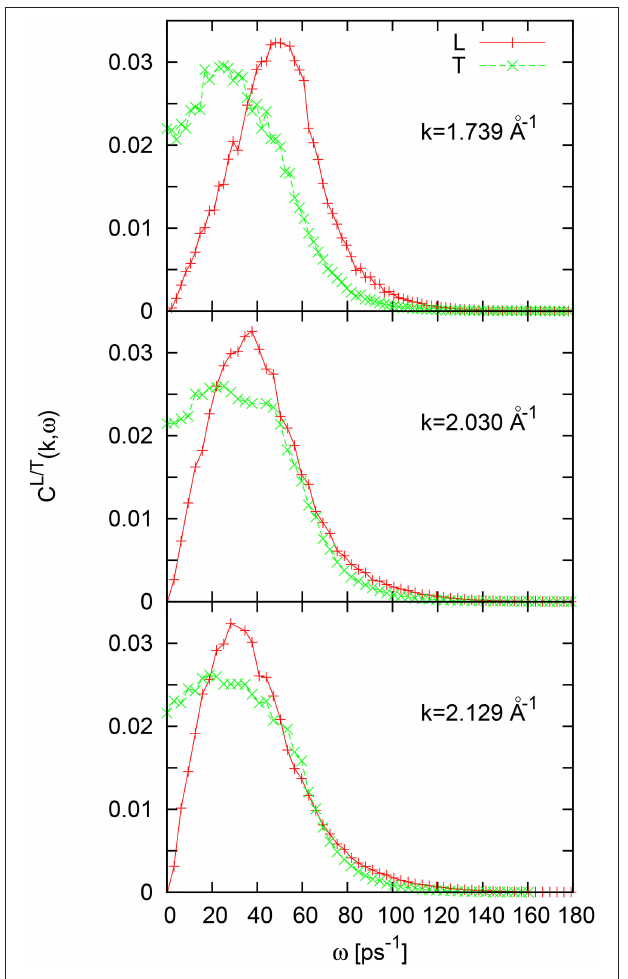
FIGURE 3 | Longitudinal and transverse current spectral functions for liquid Al for three wave numbers in the second pseudo-Brillouin zone.